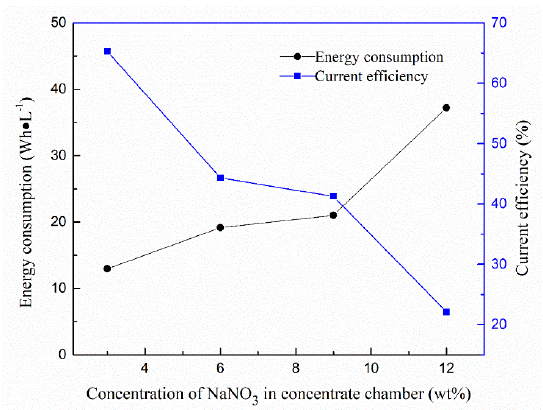
Figure 10. Energy consumption and current efficiency for different electrolyte salt concentrations. Figure 10 indicates the energy consumption and current efficiency for different electrolyte salt